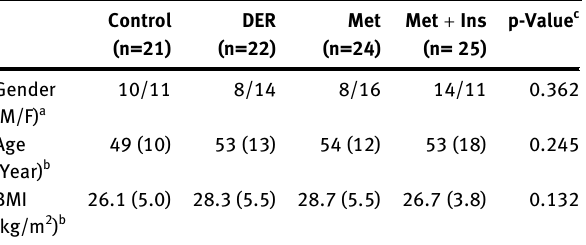
Table  : Demographic information of the study groups.